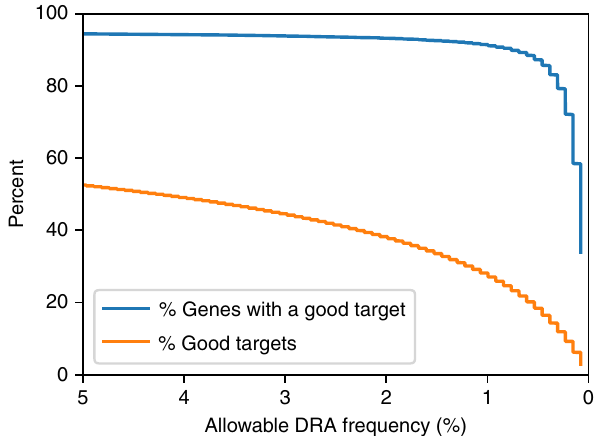
Fig. 3 Effects of polymorphisms on targets. Percent of genes containing at least one good target (blue) and percent of good targets out of possible targets as a function of DRA frequency threshold (orange). This analysis is based on N = 654 An. gambiae samples (Ag1000G data). DRA frequency threshold is the value beyond which alternative alleles are considered to be DRAs and are fi ltered out (i.e., a DRA frequency threshold of 0.01 means, alternative alleles with a frequency below 1% are ignored during fi ltering). Note the constant decline in the fraction of good targets (orange), which is not mirrored in the fraction of genes containing good targets (blue) until the DRA frequency threshold is set at <0.01. Source data are provided as a Source Data fi